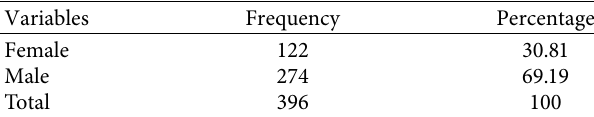
Table 3: Gender of the household head.